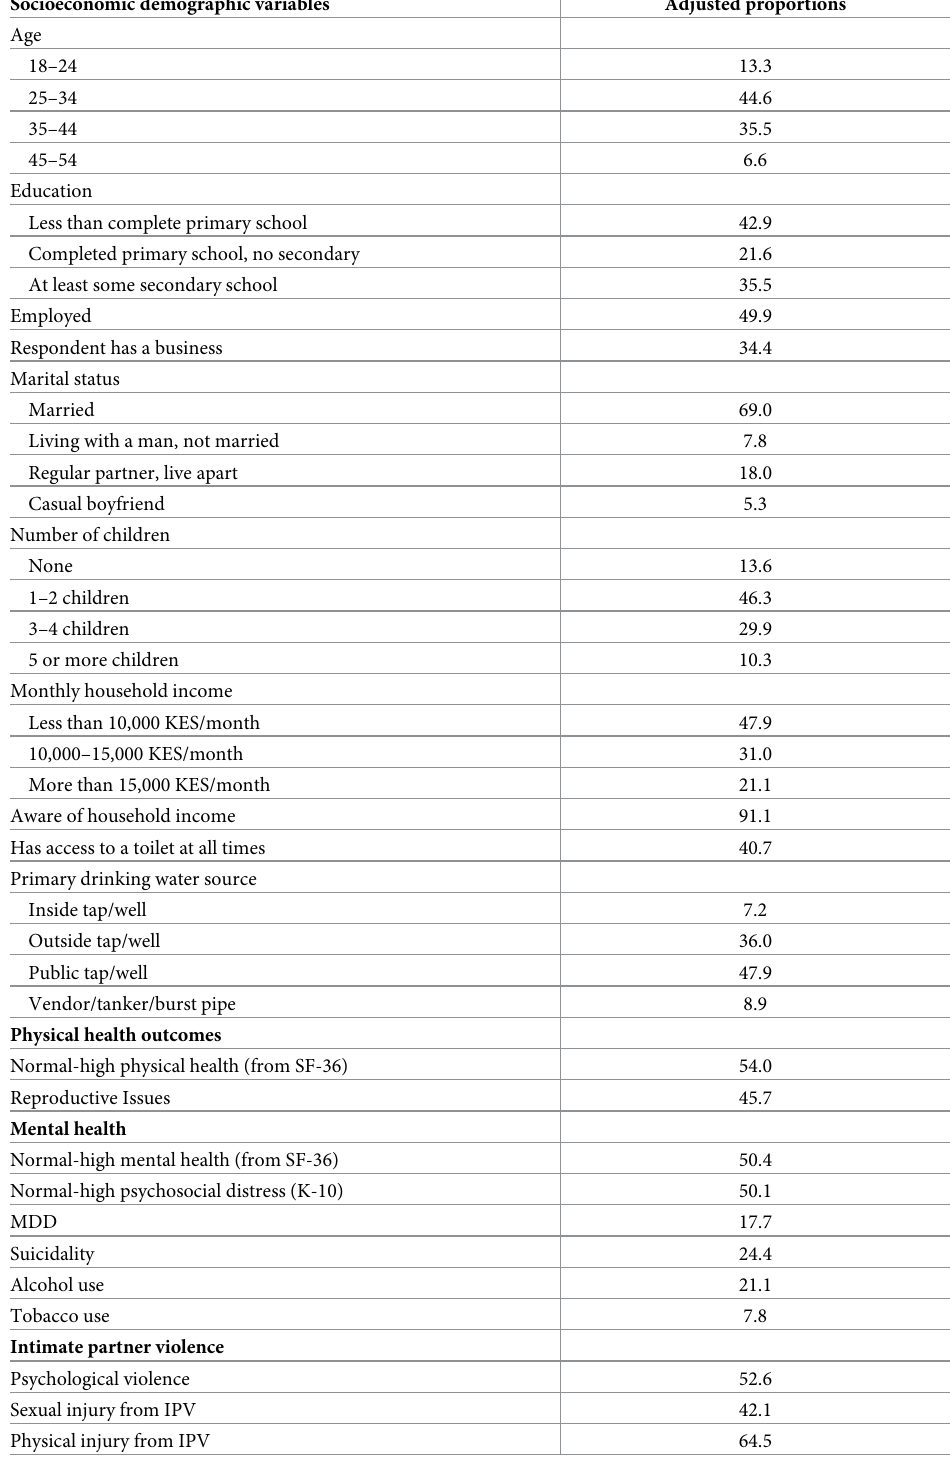
Table 1. Adjusted characteristics of sample (n =